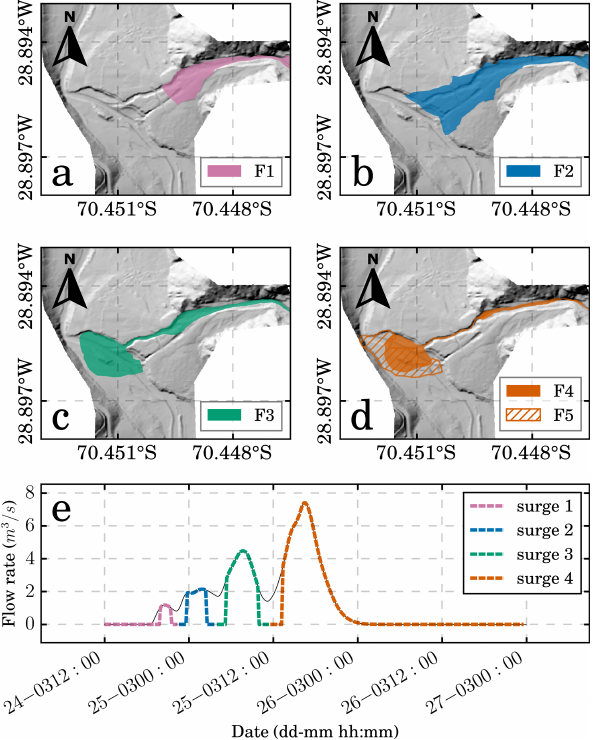
Figure 2. Available data for the 25M event in Crucecita Alta allu- vial fan. (a) The facies F1 (magenta), (b) F2 (blue), (c) F3 (green), and (d) F4 and F5 (orange) retrieved from Cabré et al. (2020a) and lidar topography surveyed by IDIEM (2019). (e) Flow hydrograph obtained from the hydrologic model performed by IDIEM (2019). The colors used to identify the facies in (a–d) depict their correla- tion with the surges in (e)